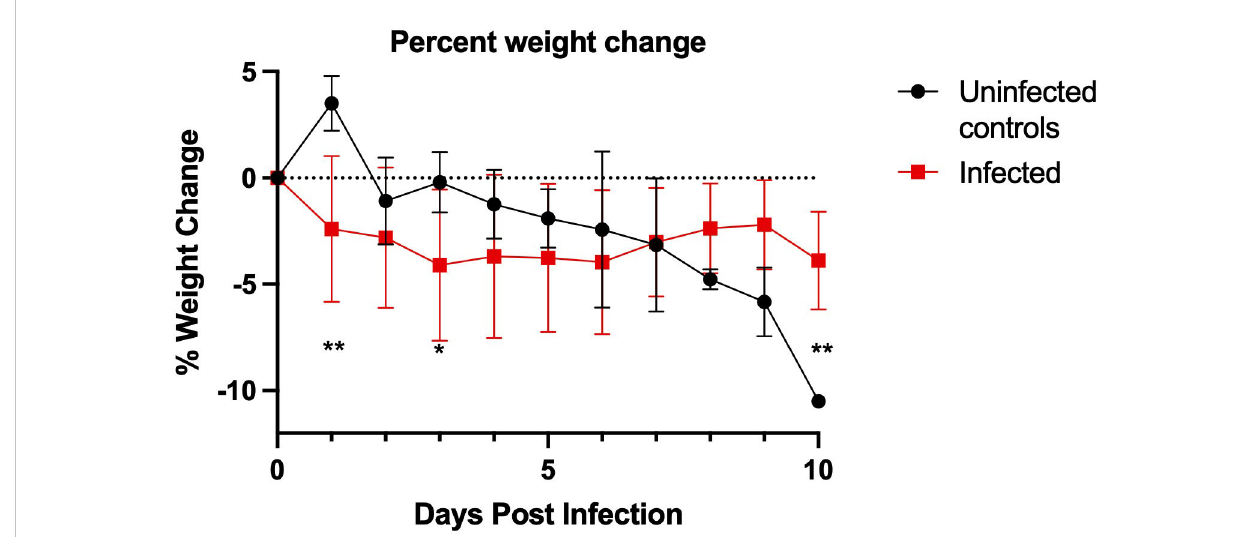
FIGURE 3 California mouse ( P. californicus insignis ) weight change during SARS-CoV-2 infection. SARS-CoV-2-challenged California mice had signi fi cantly greater weight loss on day 1 post-challenge (**p=0.003) and day 3 post-challenge (*p=0.047) as compared to the uninfected controls. The uninfected control group had signi fi cantly more weight loss than the challenged group at day 10 post-challenge (P=0.008). P-values calculated by unpaired t-test. Points represent mean weight change of the group. For the infected group, n=18 for days 0-3, n=12 for days 4-6, and n=6 for days 7-10. For the uninfected control group, n=4 for days 0-3 and n=2 for days 4-10.